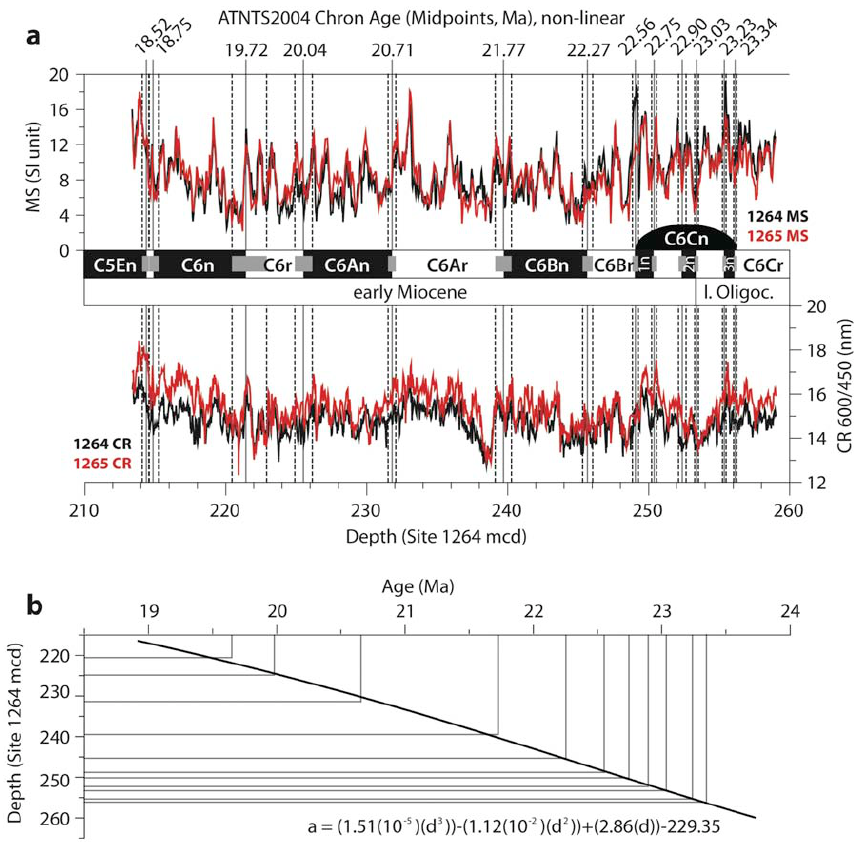
Fig. 2. Age model. (a) Transfer of the magnetostratigraphy (Bowles, 2006) from Site 1265 to Site 1264 by means of magnetic susceptibility (MS) and 600/450nm colour reflectance (CR) pattern matching. Depth scale is in meters composite depth (mcd). Please note: by trans- ferring the magnetostratigraphic mid-points from Site 1265mcd to Site 1264mcd, they may not look like “mid-points” on Site 1264mcd. (b) 3rd order polynomial fit of depth “ d ” through ATNTS2004 (Lourens et al., 2004) chron ages “ a